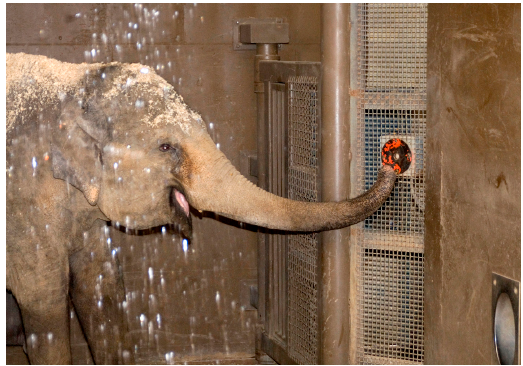
Figure 1. Elephant-activated shower at Columbus Zoo (Photo: H. Peachy).